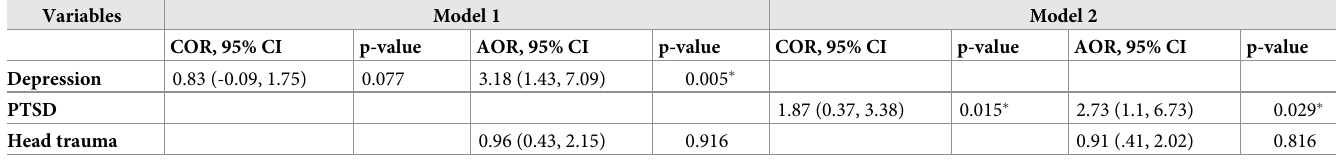
Table 3. Neuropsychiatric associations with memory